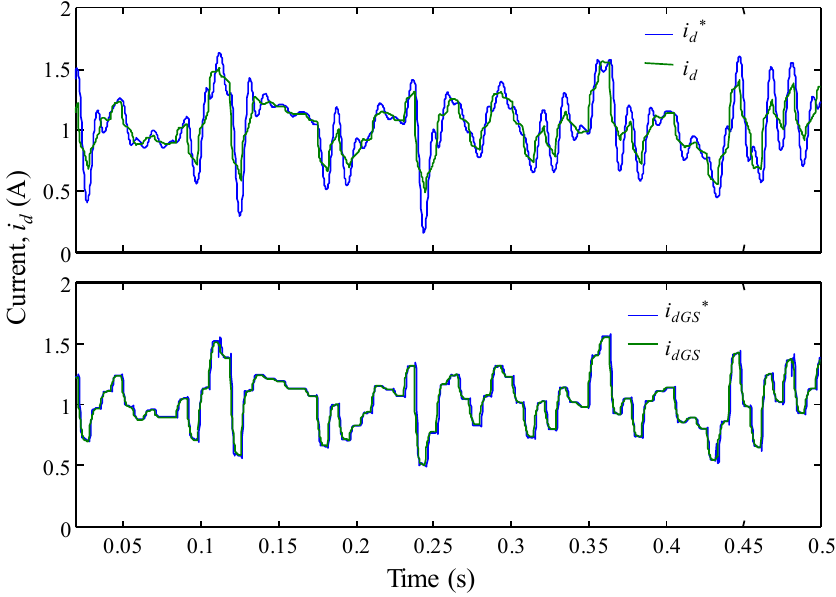
Figure 15. d axis current obtained with the two different controllers in the presence of a current disturbance corresponding to